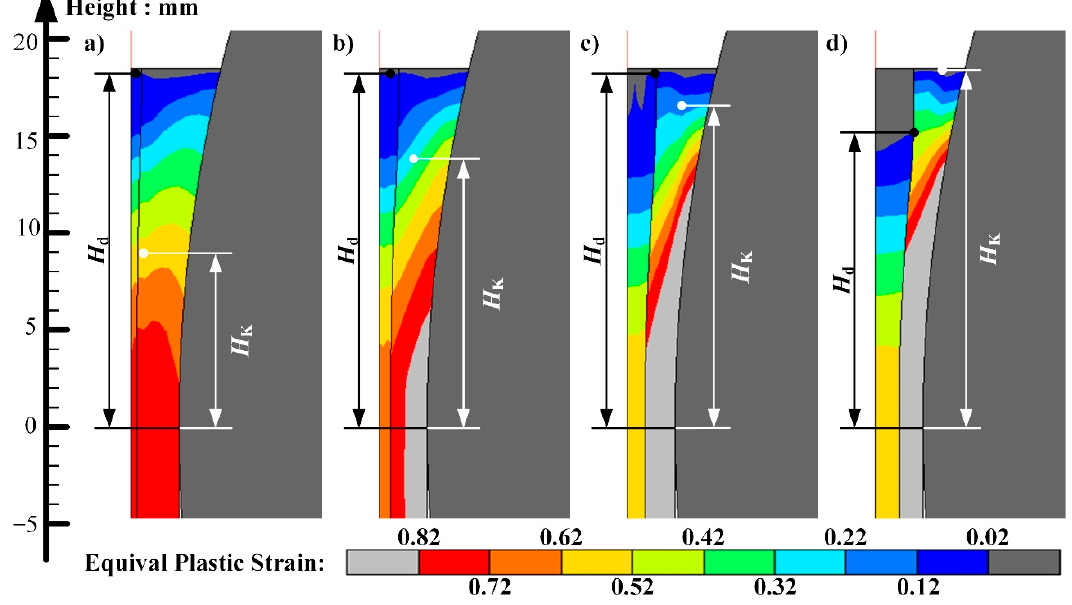
Figure 13. Contour bands of LSL-TRC strain distribution with different core thickness. ( a ) H 3003 = 1.0 mm; ( b ) H 3003 = 2.0 mm; ( c ) H 3003 = 3.0 mm; ( d ) H 3003 = 4.0 mm.